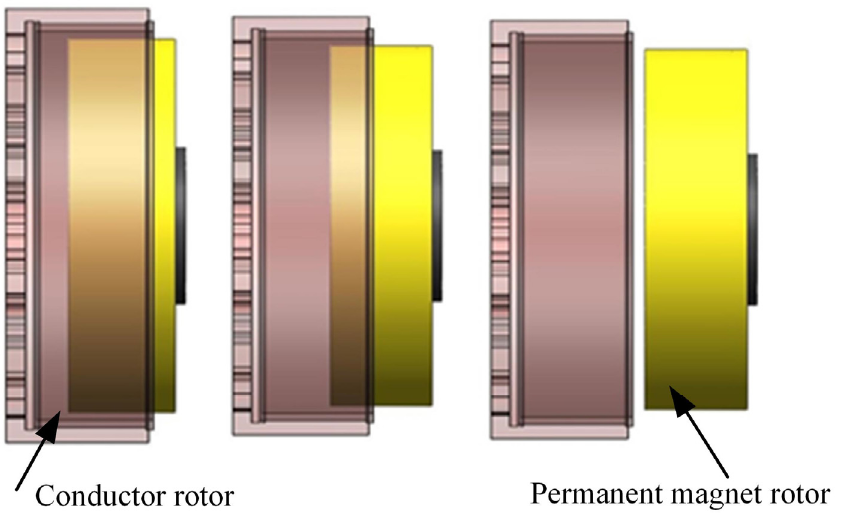
Figure 2. Speed regulation principle of CPMG.